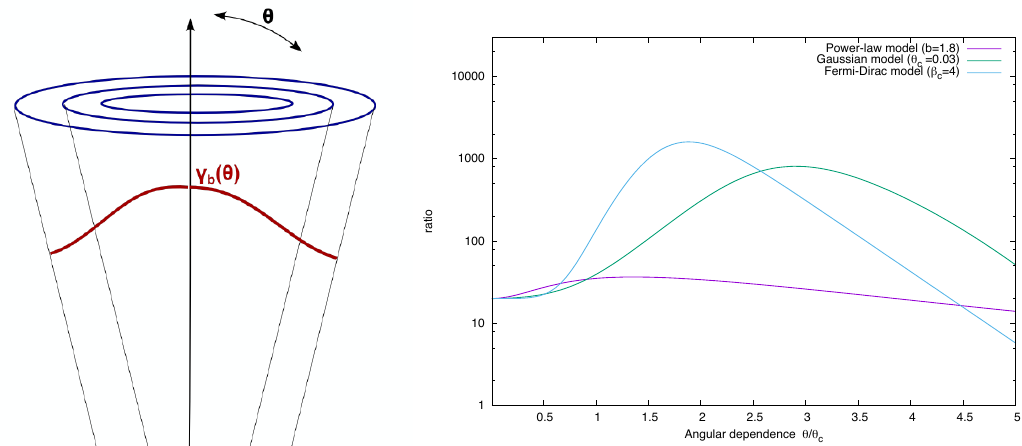
Figure 6. Left: Illustration of a simple conical flow whose radial outflow speeds varies with polar angle θ . Right: Ratio of viscous shear gain versus adiabatic losses multiplied by ( r / λ (cid:48) ), illustrated assuming a core angle θ c = 0.03 rad and an on-axis flow Lorentz factor γ b = 30. A non-axis preference becomes particularly evident for a Gaussian or Fermi-Dirac shaped flow profile. From Ref. [28].